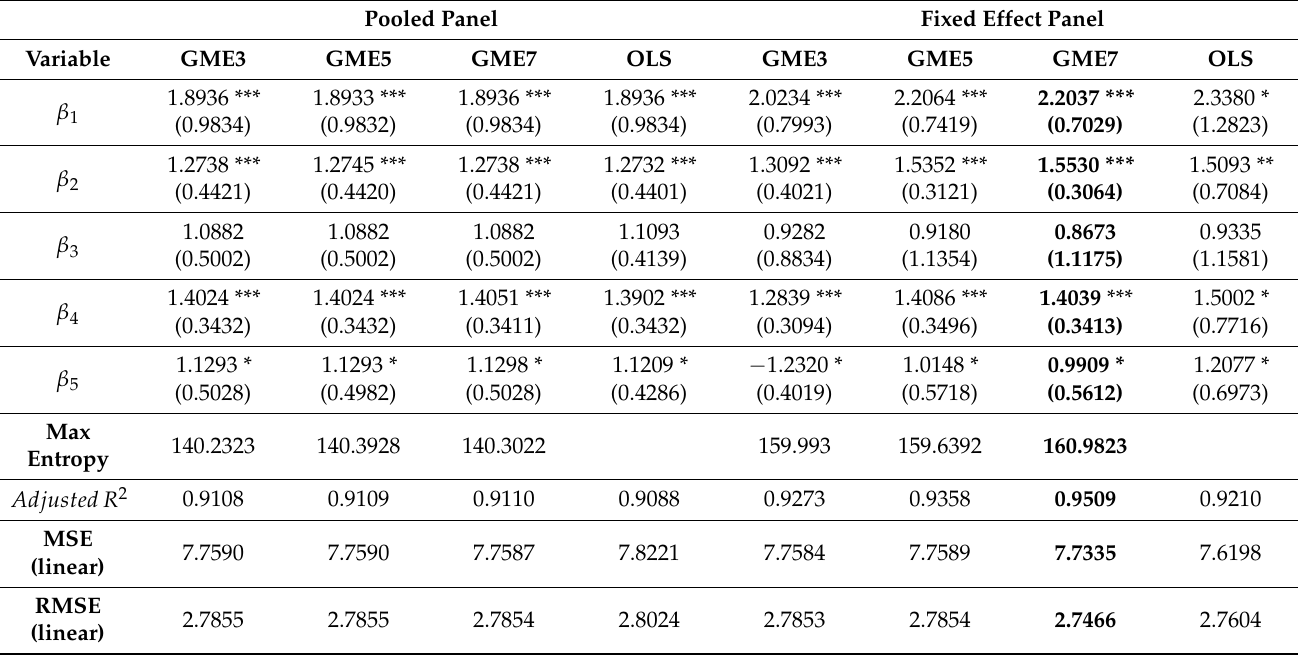
Table 5. Panel linear regreession with pooled GME, Fixed effect GME, and OLS estimates. Pooled